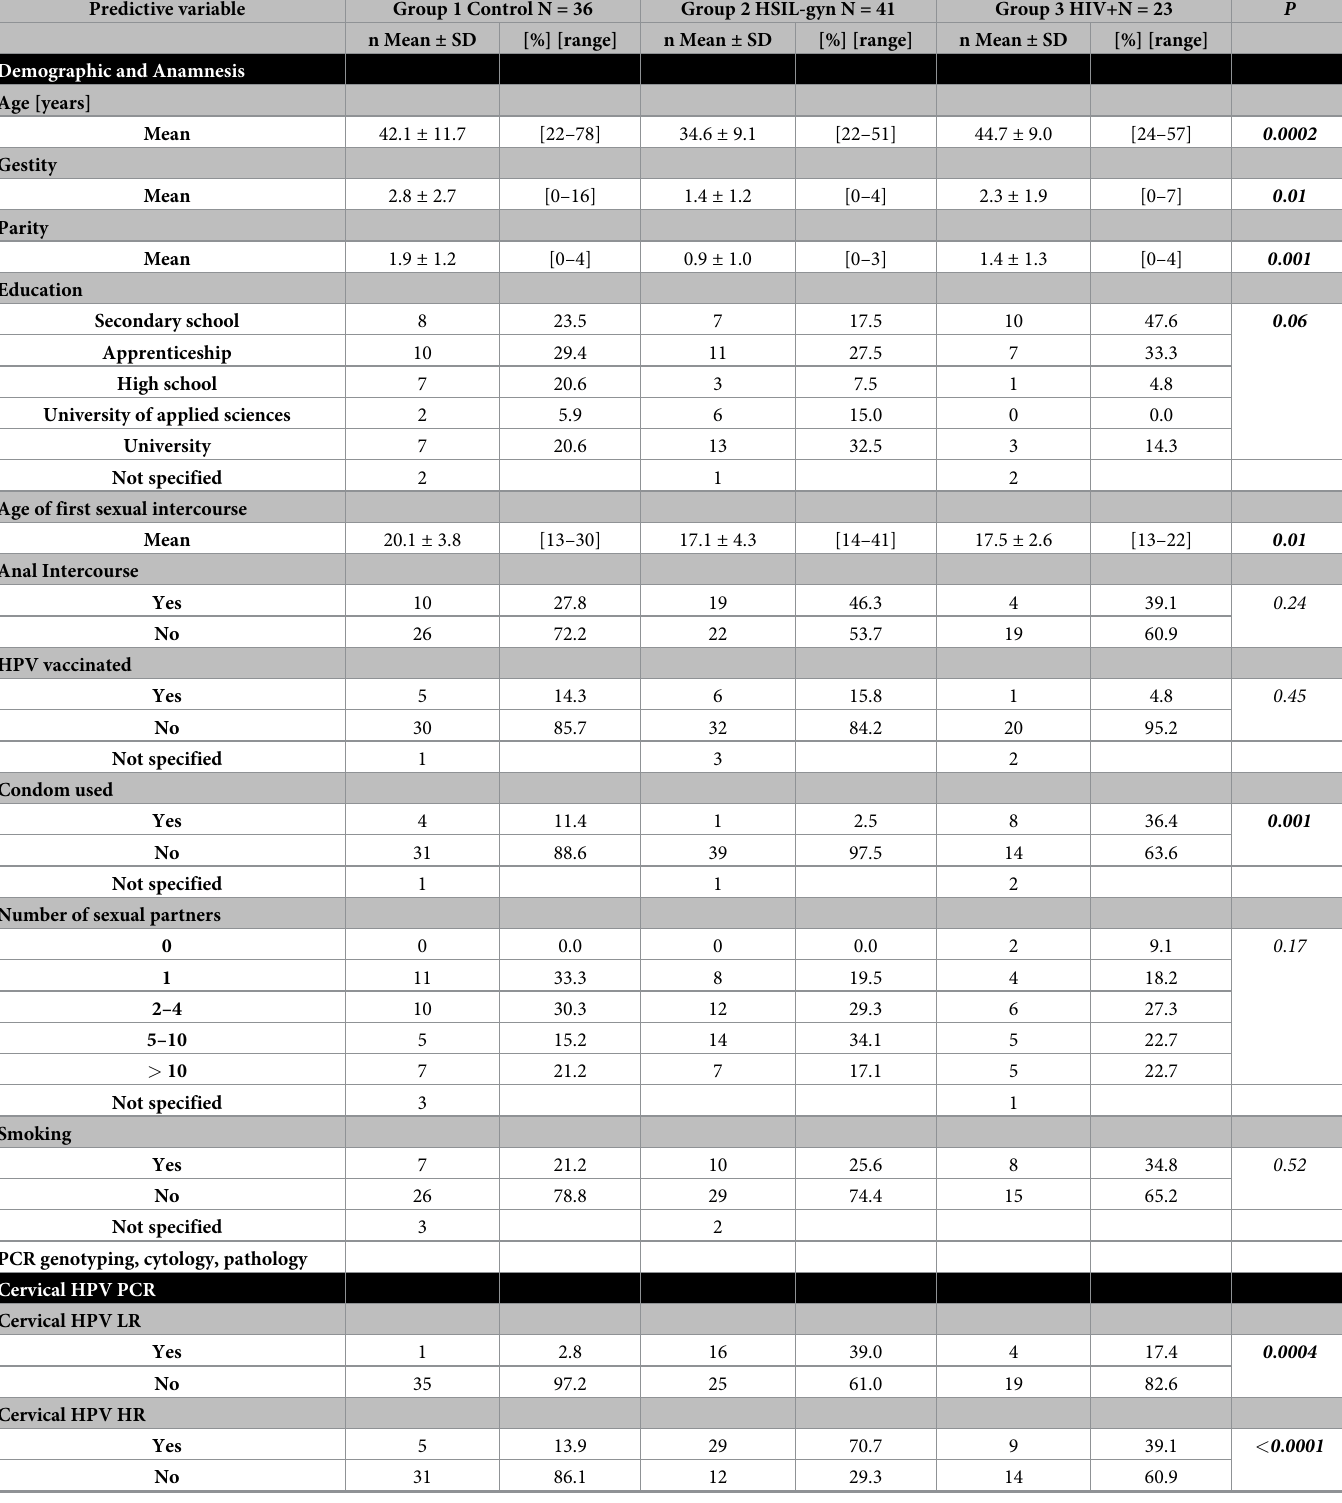
Table 3. Sub-groups univariate analysis of factors associated with cervical HPV-HR. Predictive